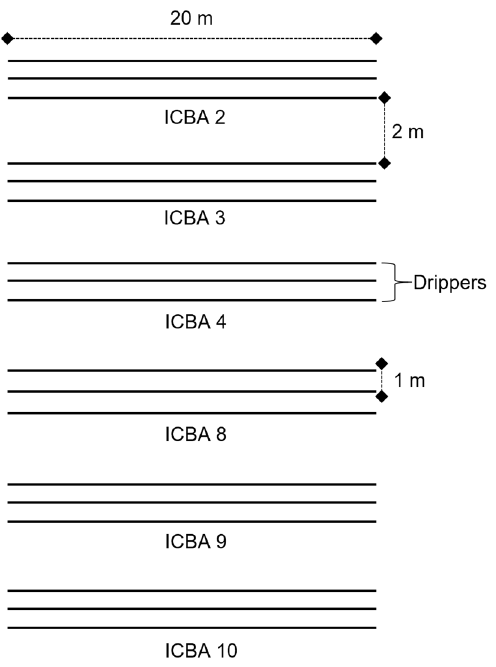
Figure A2. Salicornia field layout at Mubarak Valley in Marsa Alam in Egypt.